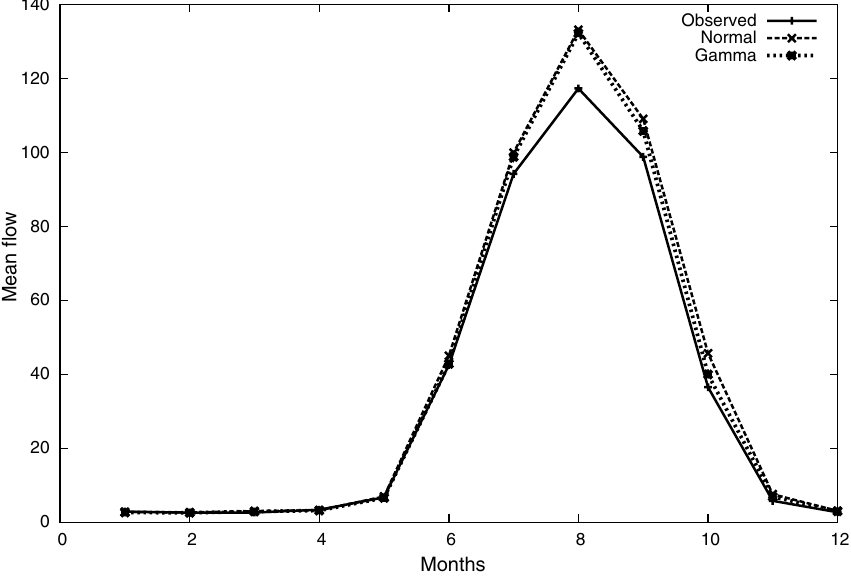
Fig. 2 Historical and gener- ated monthly means of flows in Konar River (single-site